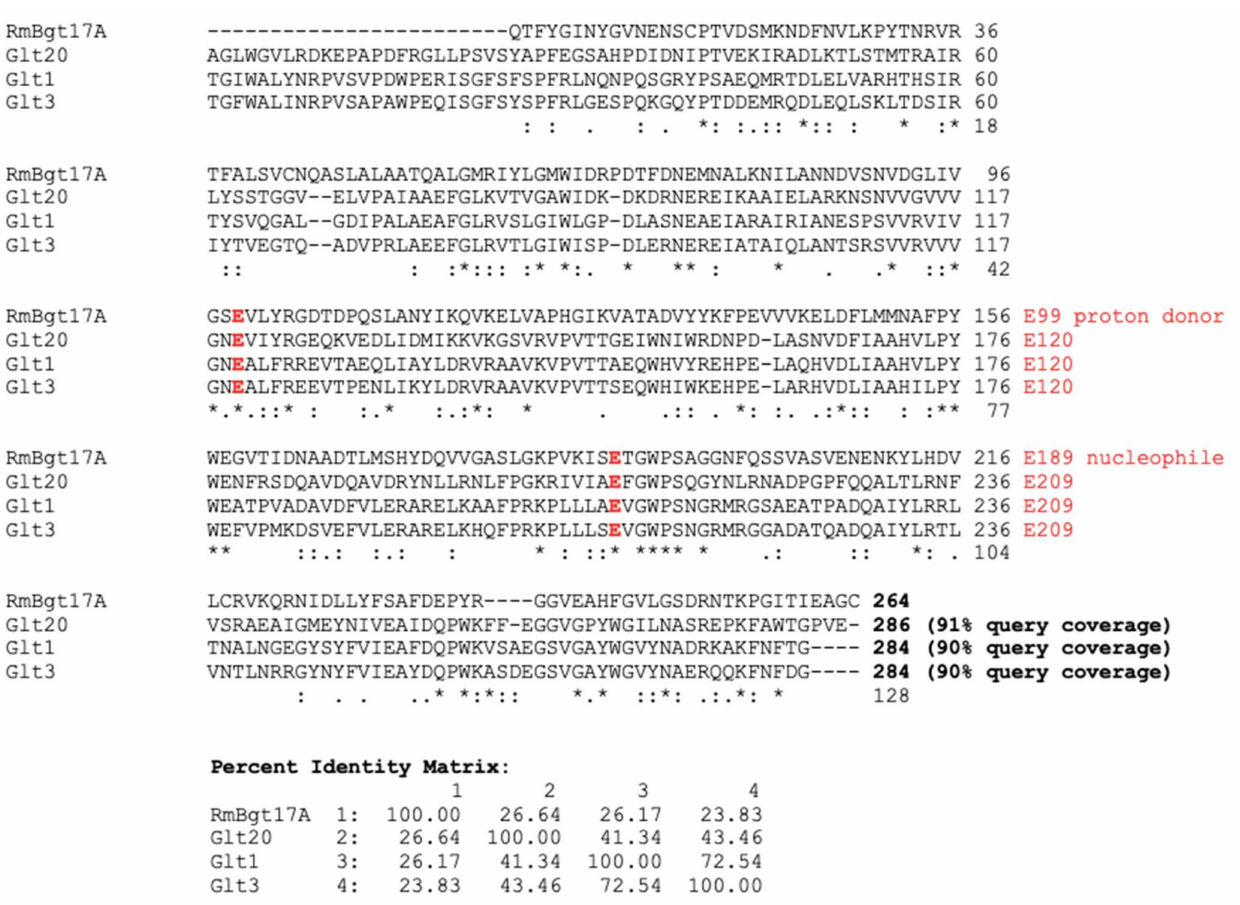
Figure 1. A CLUSTAL OMEGA multiple sequence alignment displaying the amino acid sequences of the modeled proteins (Glt1, Glt3 and Glt20) and the structure determined Rm Bgt17A (PDB: 4WTP, 4WTR, 4WTS), 264 AA, that was used as main template. Where (*) denotes conserved or identical amino acid, (:) conservative or amino acid with similar biochemical property, and (.) semiconservative amino acid. Alignment data displaying the amino acid residue identity between the respective sequence are displayed